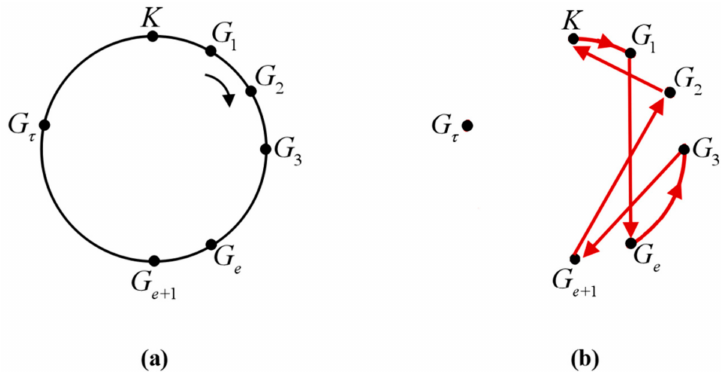
Figure 3. A generation tree basic structure loop and tour route connecting lines. ( a ) The generation tree basic structure loop composed by clustering center K and τ seed tourist sites G e , which is ordered by serial numbers of K and G e . In the process of the algorithm, the connecting arc and line can be clipped and connected. ( b ) The closed-loop path composed by some arcs and lines of the basic structure loop under the control of the